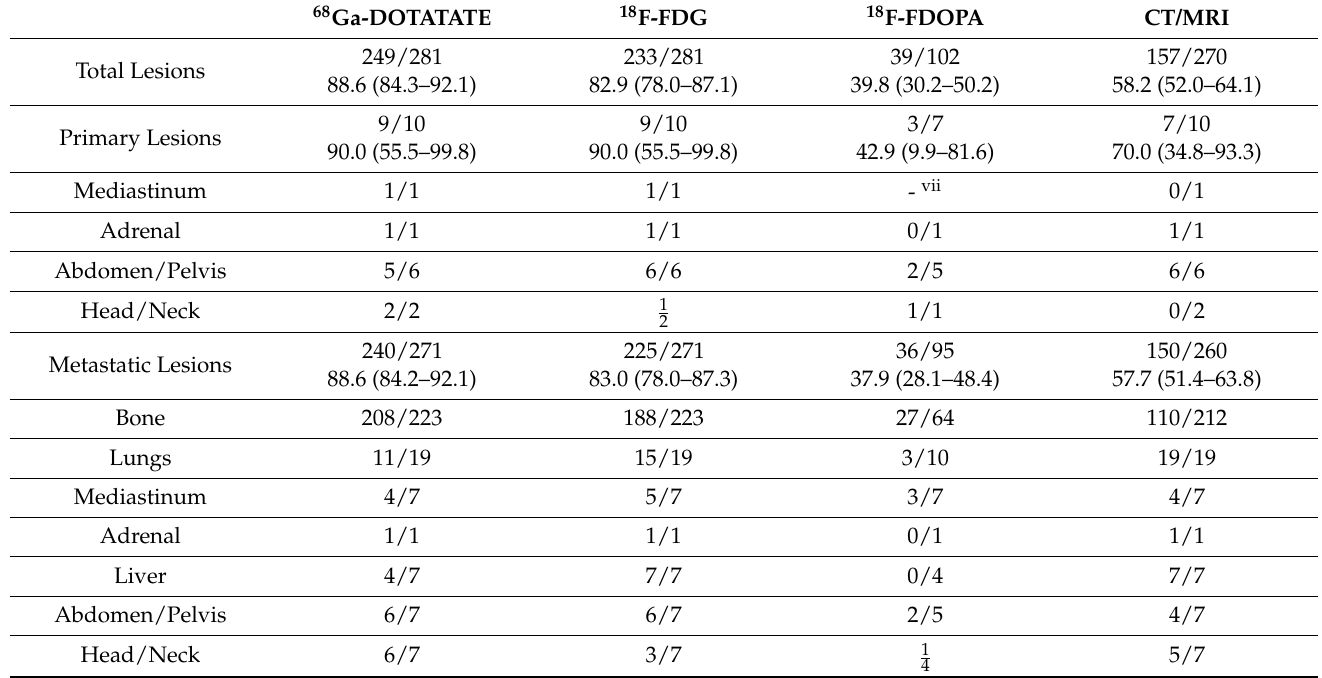
Table 2. Lesion analysis displaying detection rates and confidence intervals by imaging modalities categorized by total, primary, and metastatic lesions in 11 patients. Further subcategorization of which region the primary and metastatic lesions were located, and their detection rates are shown. 68 Ga-DOTATATE 18